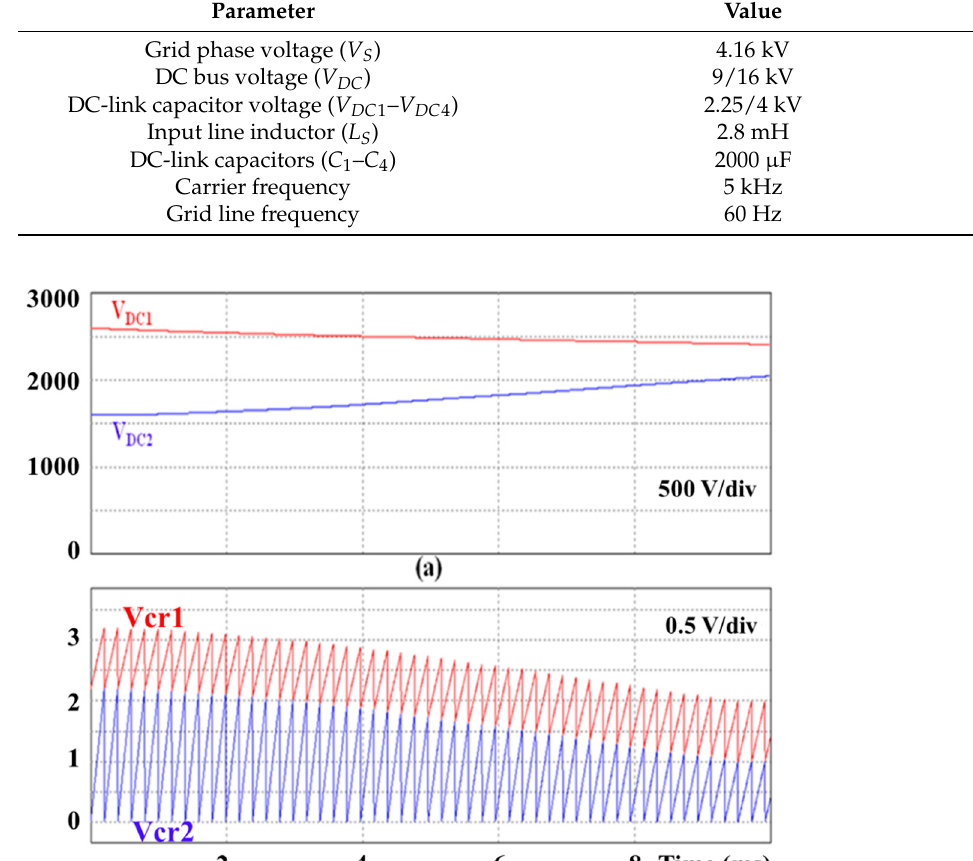
Table 3. Parameters of the simulation system.